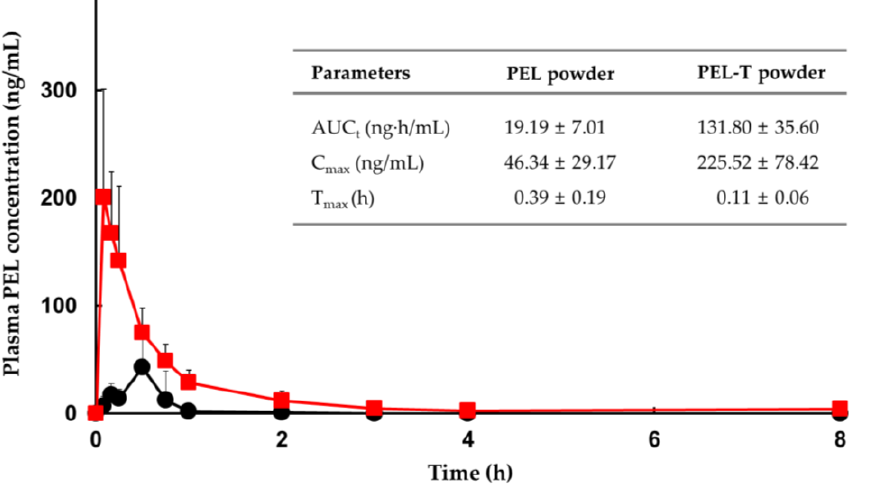
Figure 3. ( a ) Damage area (%) in the gastric mucosal injury test of rats, which was assessed using the image program (ImageJ software). Each value represents the mean ± S.D. ( n = 10) (*** p < 0.001 level compared to C; * p < 0.05 level compared to PEL; ns, no significant difference). ( b ) Repre- sentative gastric mucosal lesion photographs of each group; C, normal control.